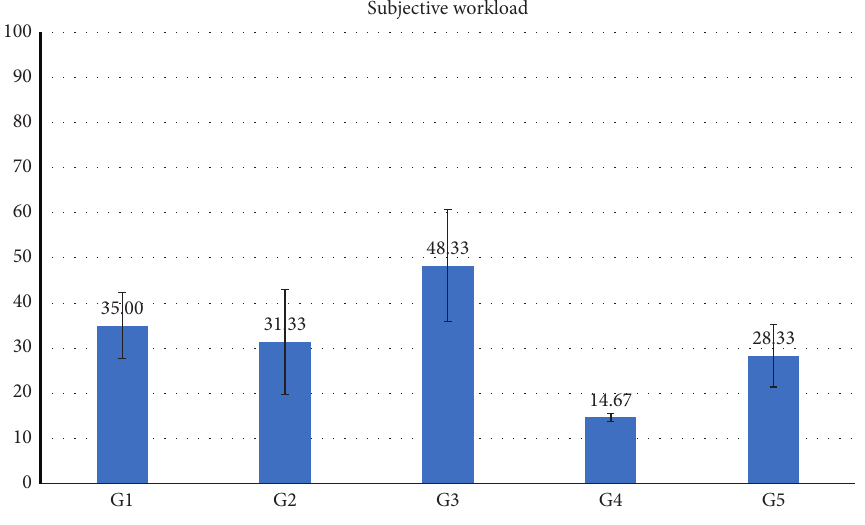
Figure 9: Subjective workload as perceived by the five